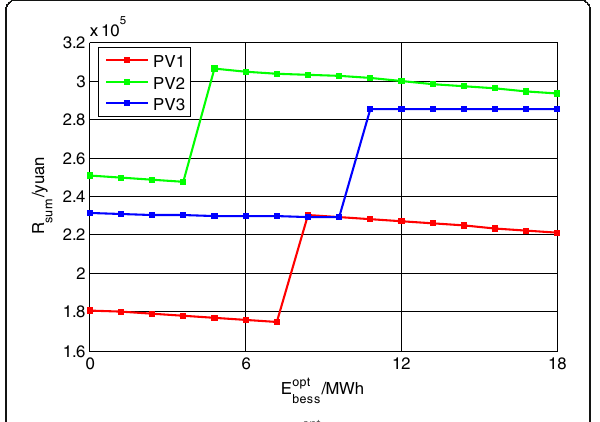
− R sum under different actual bess